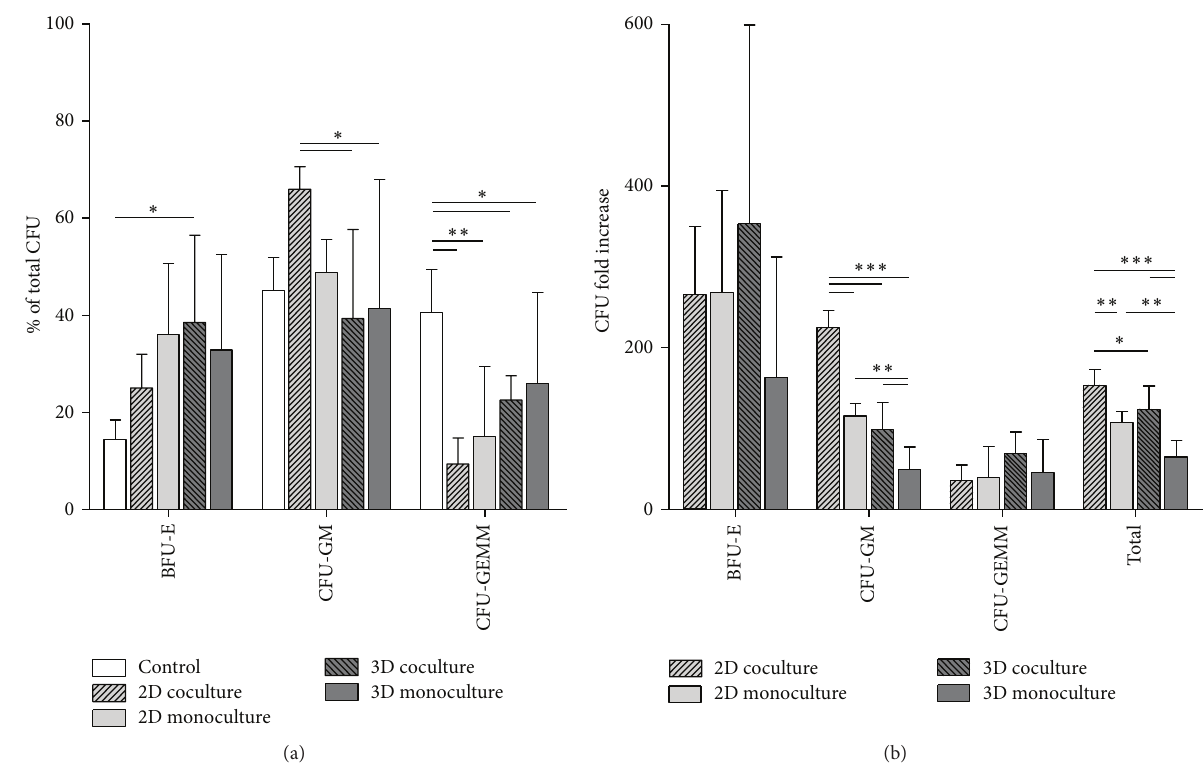
Figure 6: The 3D model is not favorable for the enhancement of primitive progenitors. Multilineage differentiation capacity of 10 3 HSPCs expanded in the hanging drop model or in a 2D culture plate was investigated after one week of culture with or without MSCs (coculture and monoculture, resp.) in a CFU assay. Results were compared to the CFU forming potential of 10 3 freshly isolated cord blood-derived HSPCs (control). (a) The BFU-E percentage of the total CFU number increased after ex vivo expansion at the expense of CFU-GEMM for all culture conditions. The CFU-GM percentage of the total CFU number was considerably augmented only for HSPCs in 2D coculture. (b) The CFU fold increase was obtained by comparison with colony numbers of nonexpanded cells and was calculated using the proliferation rate of HSPCs under the respective culture conditions. HSPCs expanded on an adherent MSC layer produced the largest number of total colonies. Values are expressed as mean ± standard deviation of three independent experiments from three donors. One-way ANOVA was applied for statistical analysis ( ∗ 𝑝 < 0.05 ; ∗∗ 𝑝 < 0.01 ; ∗∗∗ 𝑝 < 0.001